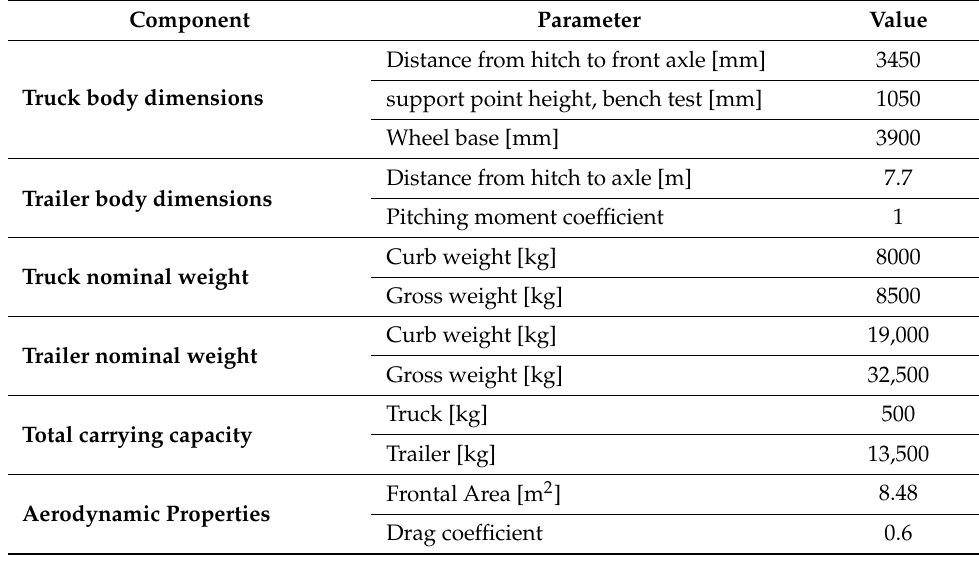
Figure 1. Flow diagram of modelling process. Table 1. Truck and trailer bodies technical parameters.